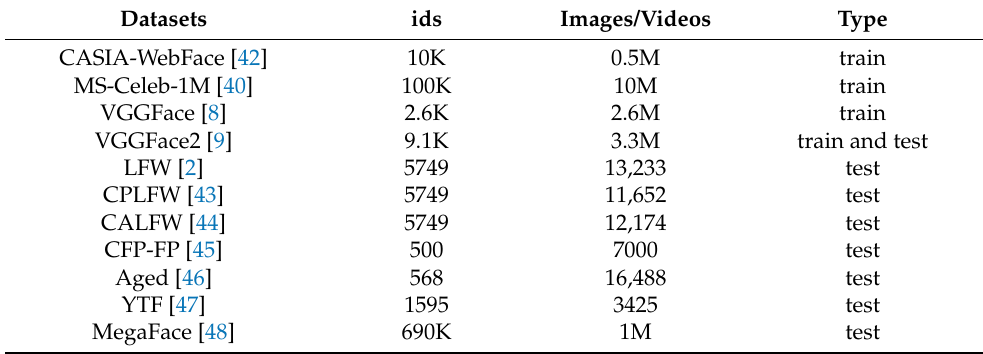
Table 2. Commonly used face